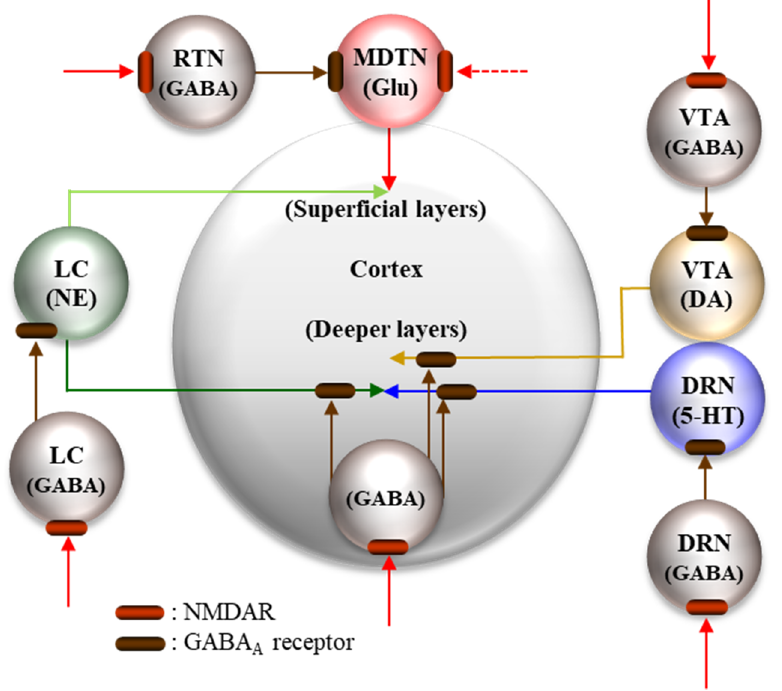
Figure 1. Schematic regulation mechanisms associated with NMDAR in neural circuits of dopaminergic (DA), serotonergic (5-HT), noradrenergic (NE) and glutamatergic (Glu) pathways to the frontal cortex (medial prefrontal cortex, insular cortex and orbitofrontal cortex). Dopaminergic (from ventral tegmental area: VTA), serotonergic (from dorsal raphe nucleus: DRN) and noradrenergic (from locus coeruleus: LC) neurones project their terminals to deeper layers of the frontal cortex, and receive regional GABAergic inhibition, which is regulated by stimulatory NMDAR. Contrary to the monoaminergic mesocortical pathway, glutamatergic neurones project terminal from the mediodorsal thalamic nucleus (MDTN) to superficial layers of the frontal cortex. Glutamatergic neurones in the MDTN receive intrathalamic GABAergic inhibition mainly from the reticular thalamic nucleus (RTN) and the MDTN, which are also regulated by NMDAR. Yellow, blue, deep green, red and brown arrows indicate the projection terminals of DA, 5-HT, LC, GABA and Glu, respectively. Light green arrow indicates the catecholaminergic co-releasing projection (NE plus DA).